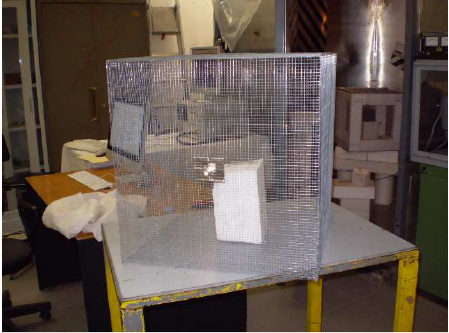
Figure 3: 5 mm metallic mesh enclosure used for the experiments.